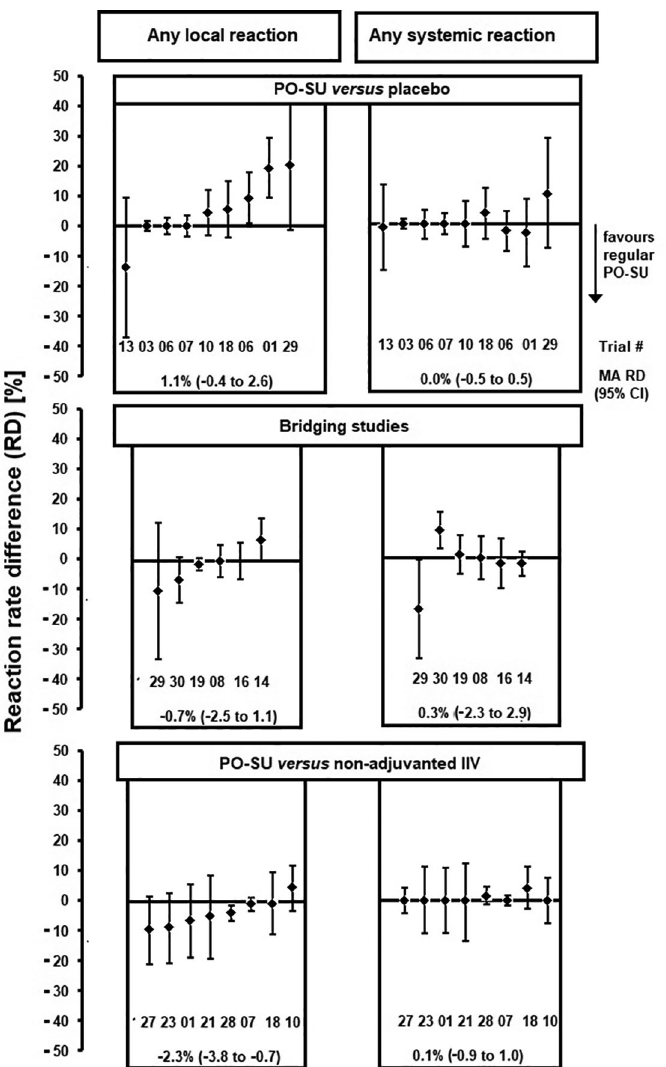
Figure 3. Randomised comparison trials (regular AZB-SU versus three comparator classes). Reaction rate difference values. Legend: Minuend: AZB-SU 1996 in trials T01, T03, T06, T07, T08, T10, T14 and T16; AZB-SU 2008 in T13, T18, T19, T21, T23, T27 and T28; AZB-SU 2018 (20 μ g HA) in T29 and T30. Subtrahend bridging studies: AZB-SU 1996 2 times 2.5 μ g HA in T08; AZB-SU 2008 in T14, T29 and T30; PO- SU TC in T16 and T19. Subtrahend non-adjuvanted IIV: whole virus in T01; subunit in T10, T18, T21, T23, T27 and T28; subunit and split combined in T07. For trial numbers, see Supplementary Materials, Figure B and C. T06 was divided into two age groups. MA RD, descriptive IV-weighted